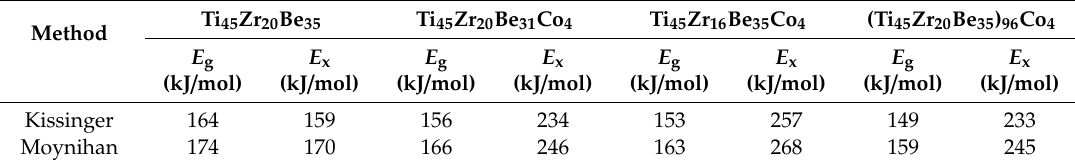
Table 6. The values of E p1 obtained using Kissinger, Moynihan, Ozawa, and Boswell methods.